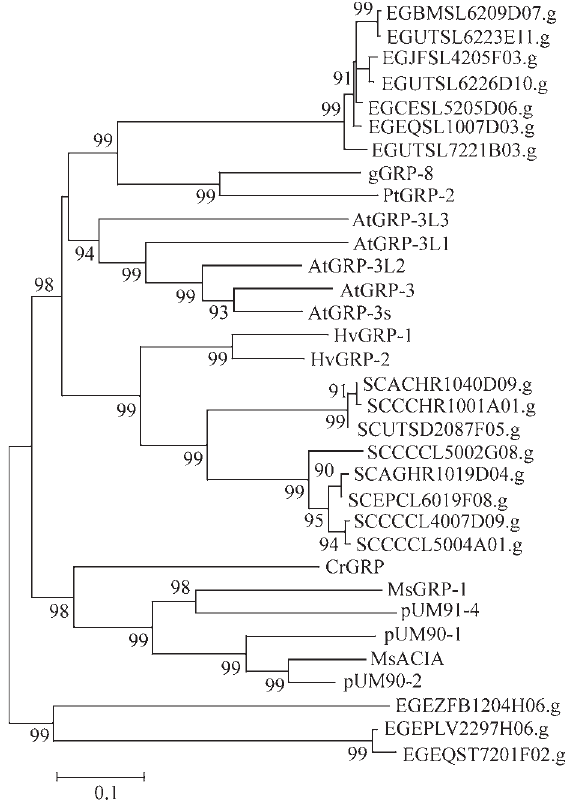
Figure 2 - Unrooted dendrogram of GRPs with C-terminal end sequences rich in cysteine. The relationships were calculated using MEGA (p dis- tance, neighbor-joining method and bootstrap test with 2000 replications, pairwise deletions). The analysis was performed based on the ClustalW alignment of the sequences. Accession numbers: Hv GRP-1 (X52580), Hv GRP-2 (Z48625), At GRP-3 (S47409), At GRP-3s (AAD11798), At GRP-3L1 (AAD24656), At GRP-3L2 (AAD24654), At GRP-3L3 (AAD24653), gGRP-8 (M37152), PtGRP-2 (S11959), Cr GRP (S04069), Ms GRP-1 (X59930), pUM91-4 (AAA32652). pUM90-1 (AAA32653), pUM90-2 (AAA32651), Ms ACIA (L03708). Sugarcane sequences are represented using SUCEST nomenclature (Fusaro et al. ,